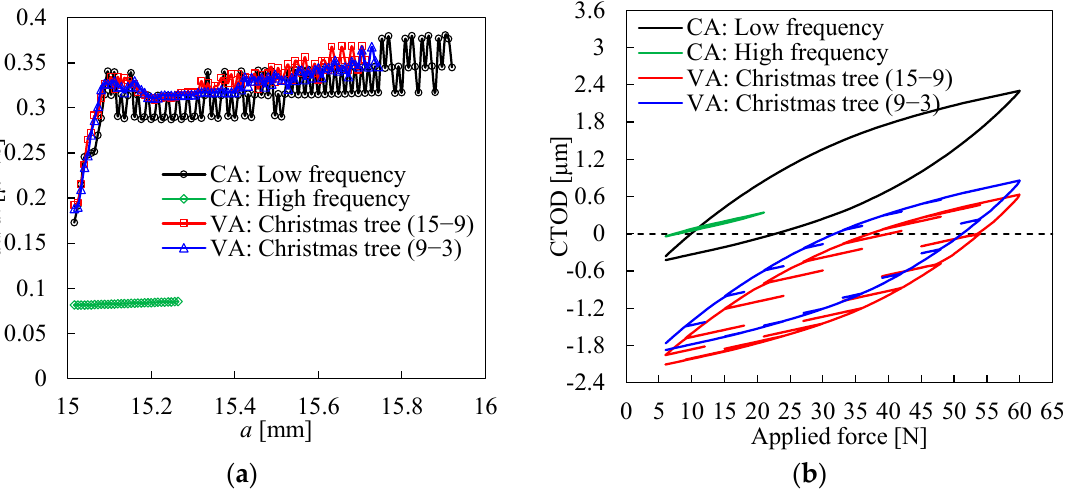
Figure 8. Comparison of different loading spectrums neglecting the contact between the crack flanks: ( a ) da/dt versus crack length; ( b ) CTOD curves for a = 15.30 mm.